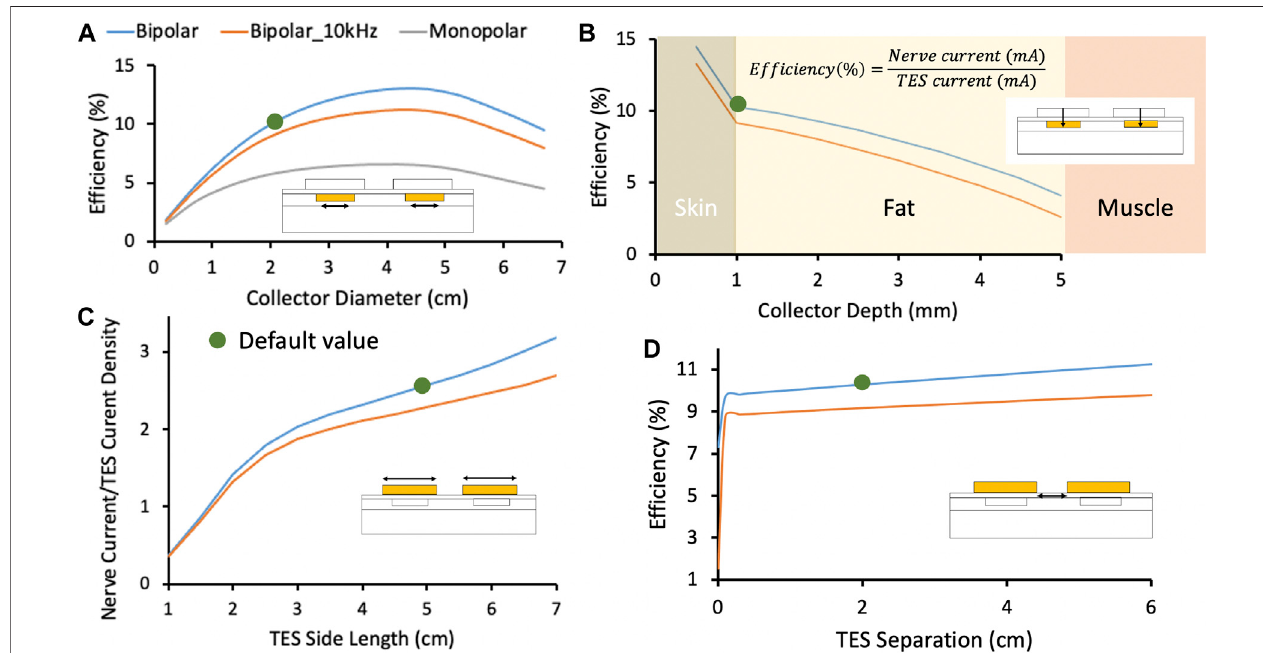
FIGURE5| Inthis fi gure,blue and orange traces represent the Injectrode system inbipolar con fi guration withstimulation at DC and 10 kHz, respectively. Thegrey tracesrepresent theInjectrodesysteminmonopolarcon fi guration withstimulationatDC.GreendotsdenotethedefaultparametersusedintheFEMmodel. (A) Change inef fi ciencywithcollectordiameter.Optimalef fi ciencywasachievedwhenthecollectordiameterapproximatelymatchedthesurfaceelectrodelength.Tissueimpedance islowerat higher frequency(orange trace at 10 kHz), whichcausedcurrent tospread moreand decreasedcaptureef fi ciency. Thecurrentwasmore volumetrically contained with a bipolar setup (blue trace compared to monopolar grey trace). (B) Ef fi ciency was highest closest to the surface electrodes and dropped quickest in the least conductive skin layer. (C) The ratio ofI Nerve to TES current density increased for larger surface electrodesizes. I Nerve isa proxy for on-targetrecruitment ofthe deep nerveand surfacecurrentdensity isaproxyforrecruitment ofcutaneousoff-targetneural fi bers. (D) Increasingseparationbetweenbipolar surfaceelectrodesincreased ef fi ciencymarginallybyincreasingtheimpedanceoftheleakagepathfromcollectortocollectorcomparedtothelow-impedance conduitformedbytheInjectrodetothe nerve. At small separations ( < 0.1 cm in this idealized model of dry skin) between the TES electrodes, current shunts super fi cially between the two electrodes and is not delivered deeper into tissue. Validated transcutaneous coupling model to investigate patient-dependent